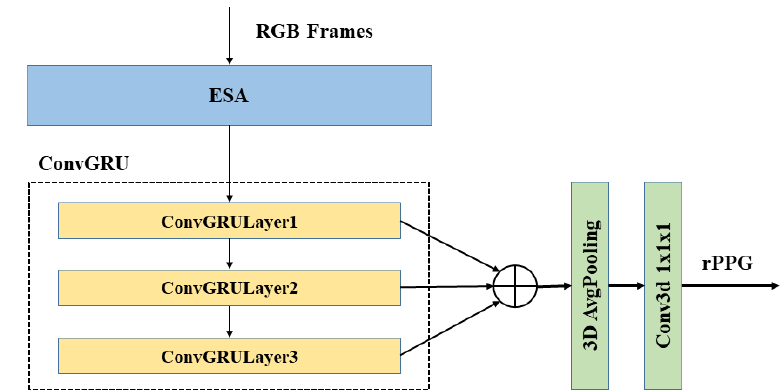
Figure 10. Structure of ESA-rPPGNet. ESA is a spatiotemporal feature extraction network composed of 3DCNN. ConvGRU is a recurrent convolutional neural network proposed in Chapter 3. Here, 3D AvgPooling is used to reduce the spatial dimension of feature map to one. Conv3d is a 3D convolution used to obtain the final rPPG signal.